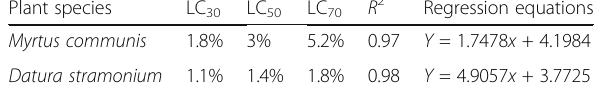
Table 1 Estimated values of lethal concentrations (%) (LC 30 , LC 50 , and LC 70 ) of Meloidogyne javanica juveniles 48-h post-exposure to different concentrations of Myrtus communis and Datura stramonium extract Plant species LC 30 LC 50 LC 70 R 2 Regression equations Myrtus communis 1.8%